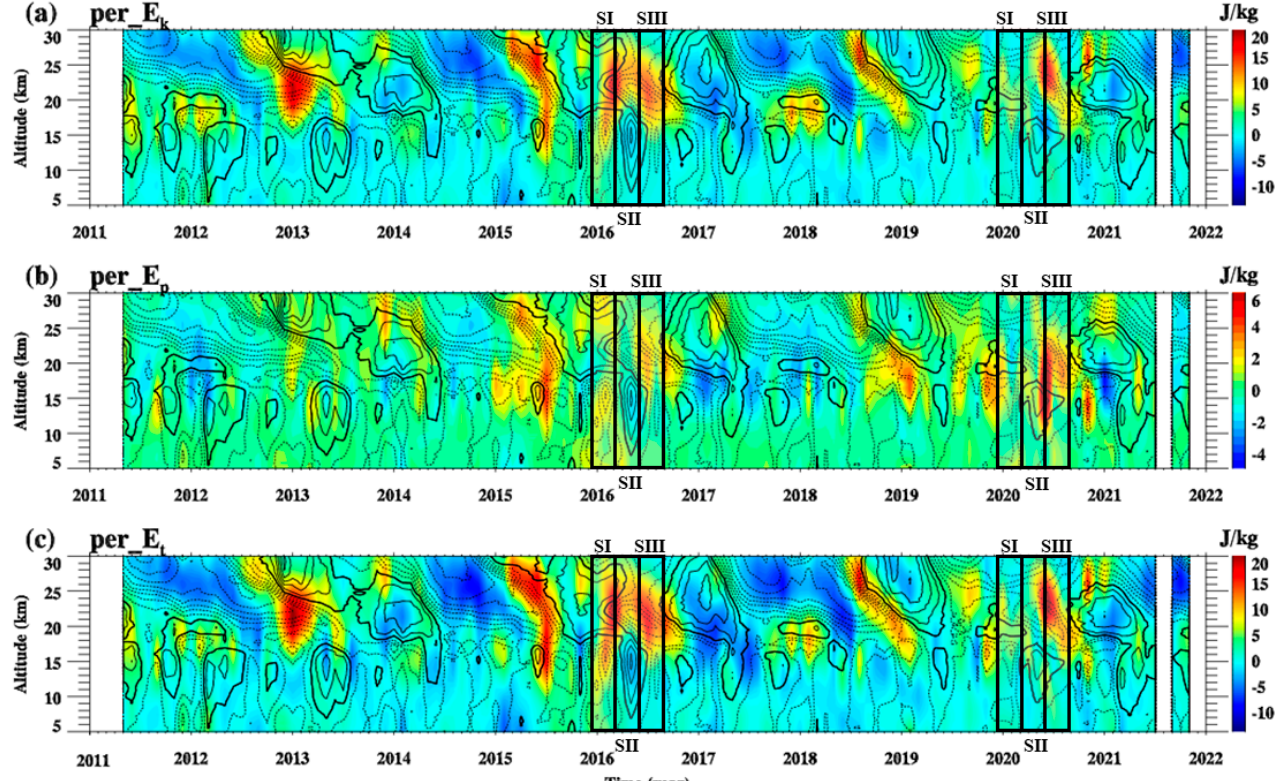
Figure 3. Temporal evolution of gravity wave ( a ) kinetic energy density anomaly, ( b ) potential energy density anomaly, and ( c ) total energy density anomaly. Color shading denotes the GWs energy density anomalies with respect to the monthly climatology (the unit is J/kg). The monthly mean zonal wind is overlaid in black contours with a contour interval of 5 m/s. The solid and dashed black contours denote the eastward and westward zonal wind, respectively. The thick contours represent zero zonal wind. The blanks indicate no observational data. Boxes indicate SI, SII, and SIII stages in panels ( a – c ).